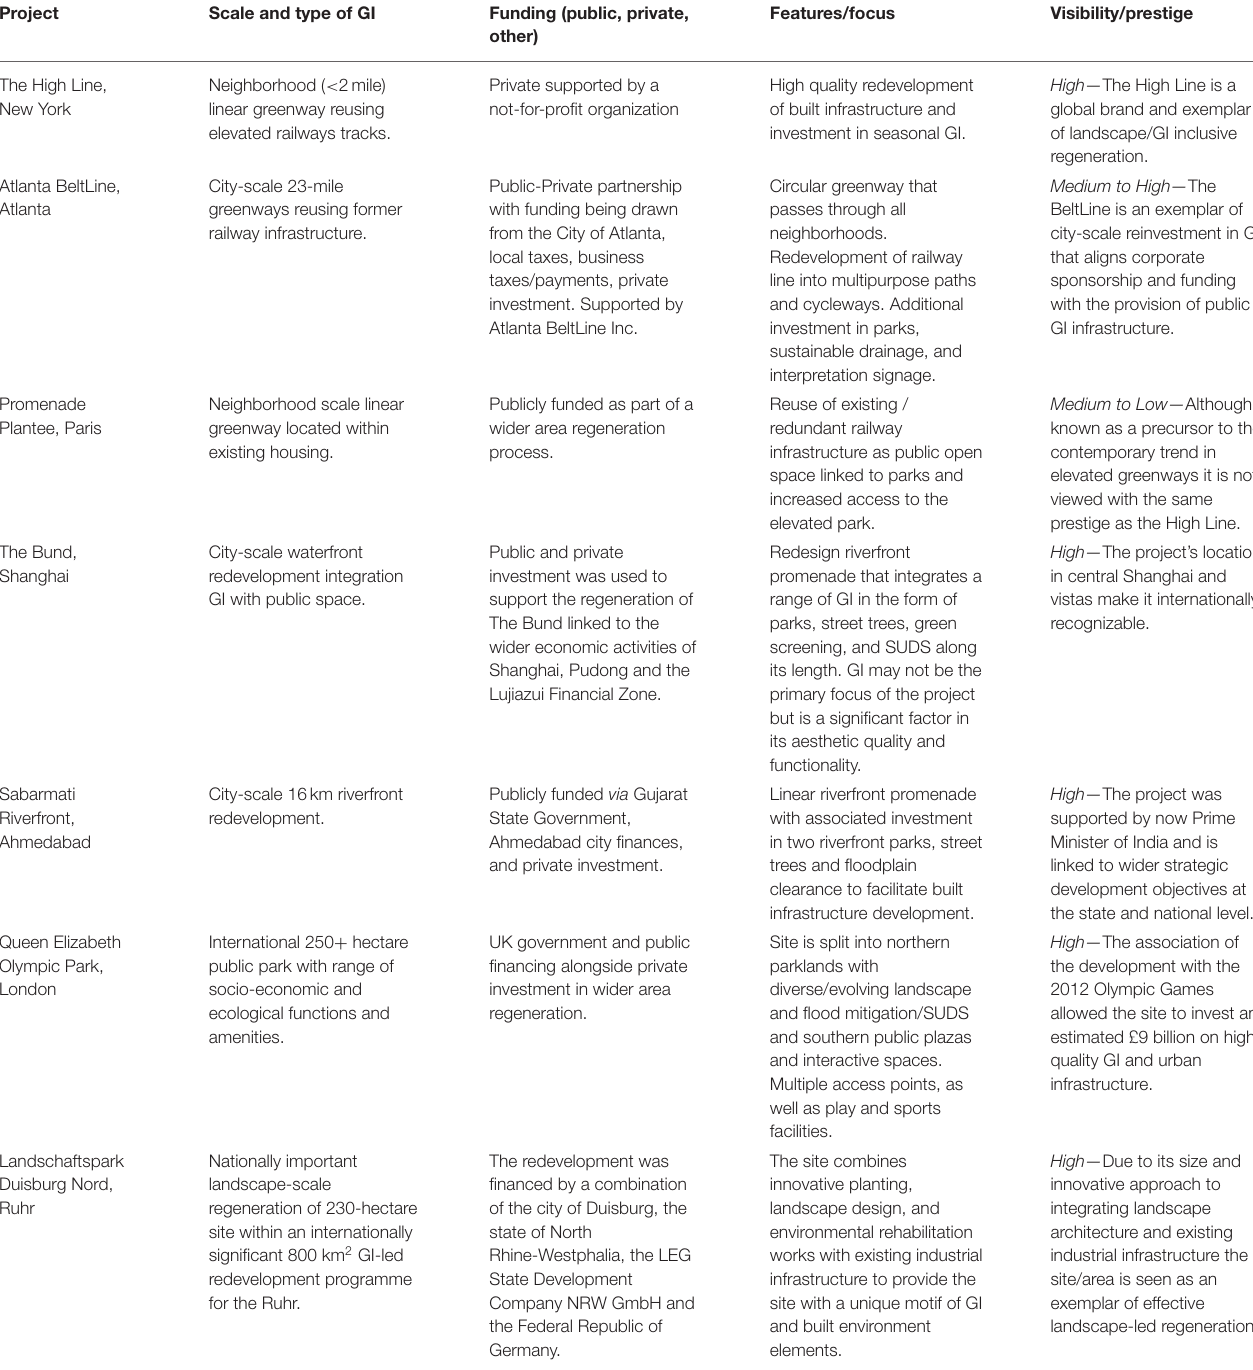
TABLE 2 | GI/landscape-led redevelopment project